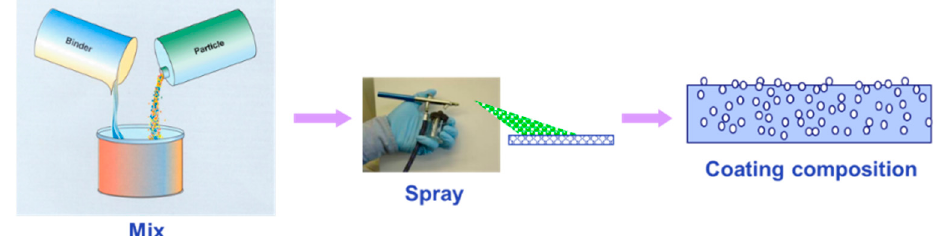
Figure 3. Schematic diagram of the preparation process of the superhydrophobic coating based on particles and binder.